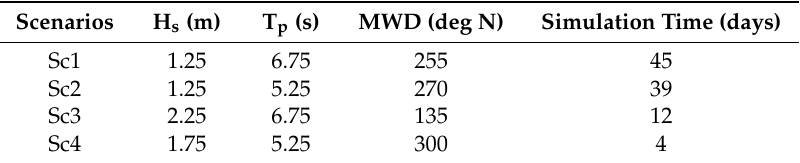
morphological changes in the case study area (H s : significant wave height (m), T p : peak wave period (s), MWD: mean wave direction (deg